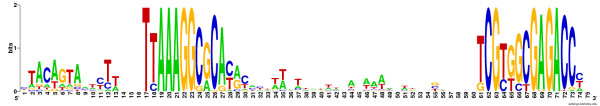
Logo of R12-5 ⇛ 12–0 with flanking motif. Logo of the 42 aligned motif pairs in the R12-5 ⇛ 12–0 orientation that were separated by 14 to 31 bp, including the 5’ flanking region. Twenty of these pairs contained the sequence TACWGTA within nine bp of the beginning of motif 12–5.